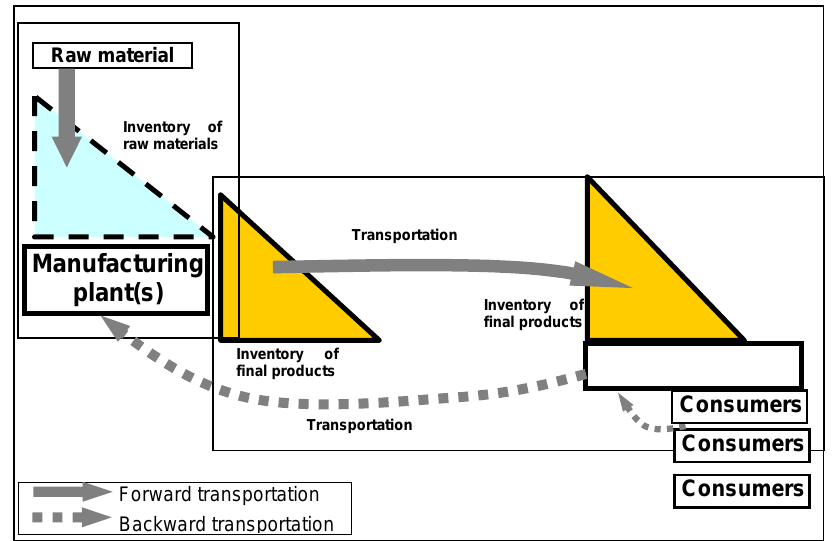
Figure 1. A simplified scheme of a given logistics